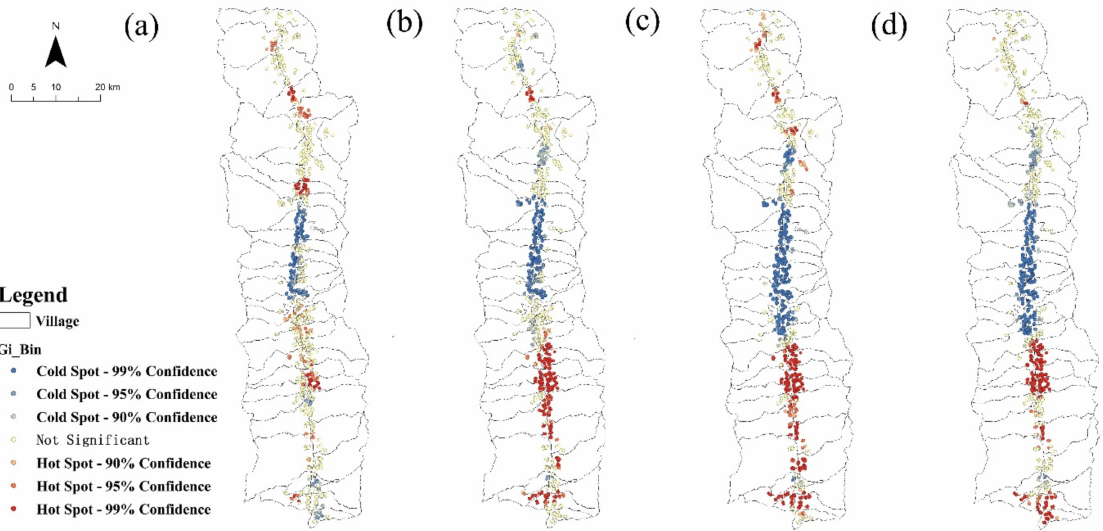
Figure 2. Hot spots of local spatial autocorrelation of farmer households from 2015 to 2018 ( a – d ). The detection results of spatial effects between explanatory variables are as